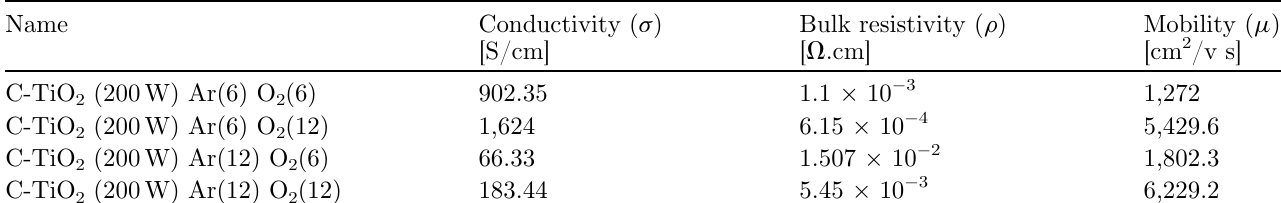
Table 3. Electrical properties of the compact TiO van-der-Pauw four-probe method.